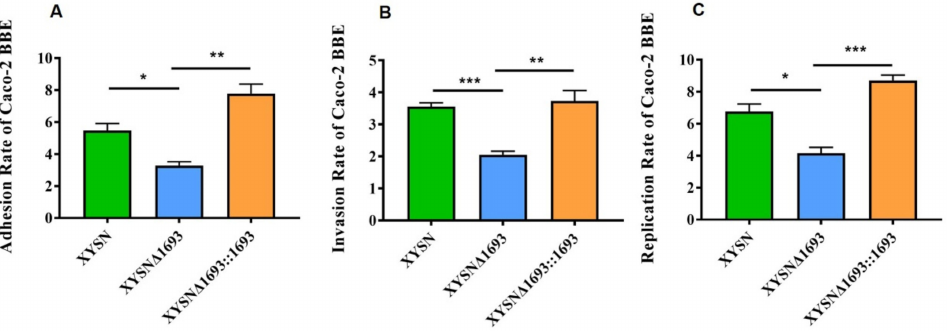
Figure 5. Adhesion, invasion and proliferation capacities of Lm. Caco-2 BBe cell was infected (MOI = 20) with Lm XYSN, XYSN ∆ 1693 and XYSN ∆ 1693 :: 1693 , respectively. The percentage of intracel- lular bacteria was calculated after 15 min of bacteria invasion or two hours of bacteria proliferation. The results are the adhesion ( A ), invasion ( B ) and replication ( C ), respectively. Among them, Lm XYSN is represented by the green bar, the mutant strain is represented by the blue bar and the complemented strain is represented by the orange bar. Error bars represented SD, n = 3 independent experiments. Statistical analysis was carried out by Student’s t -test: * p < 0.05, ** p < 0.01, *** p <